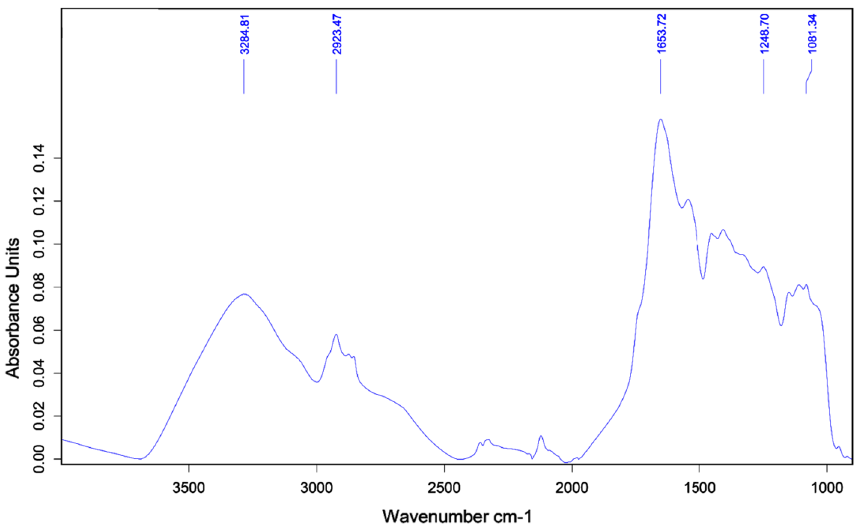
Figure 3. FTIR spectrum of AuNPs with marked positions corresponding to specific chemical bonds. The peak at 3287 cm −1 corresponds to N–H stretching and possibly to O–H stretching. The peaks at 2923 cm −1 ,